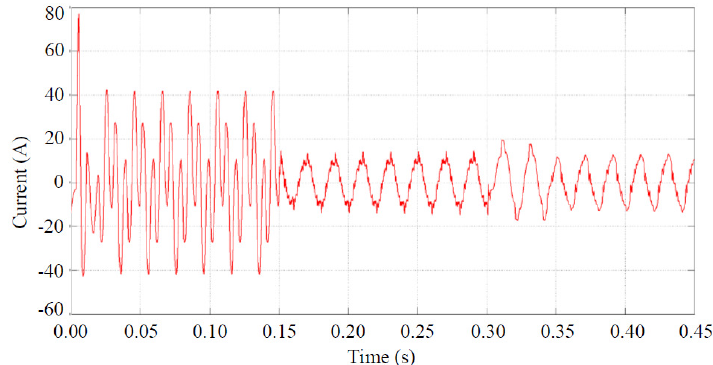
Figure 20. Source neutral current i SN